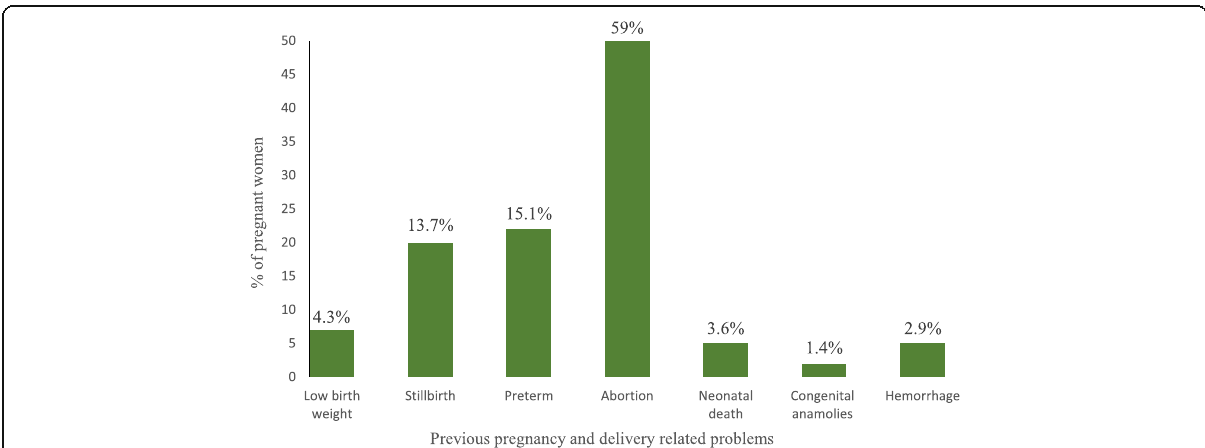
Fig. 1 Previous pregnancy- and delivery-related problems encountered among pregnant women attending antenatal care in government health centers, Addis Ababa, 2017 ( n =